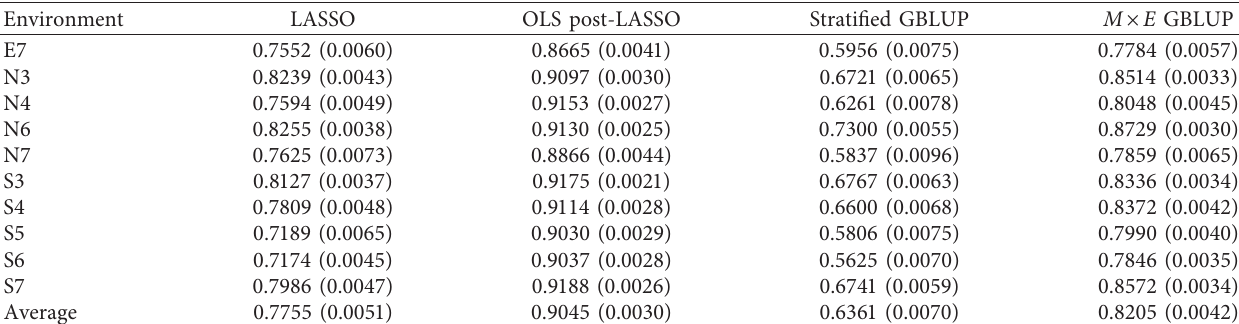
Table 4: The prediction accuracy (standard deviation, SD) of four methods for